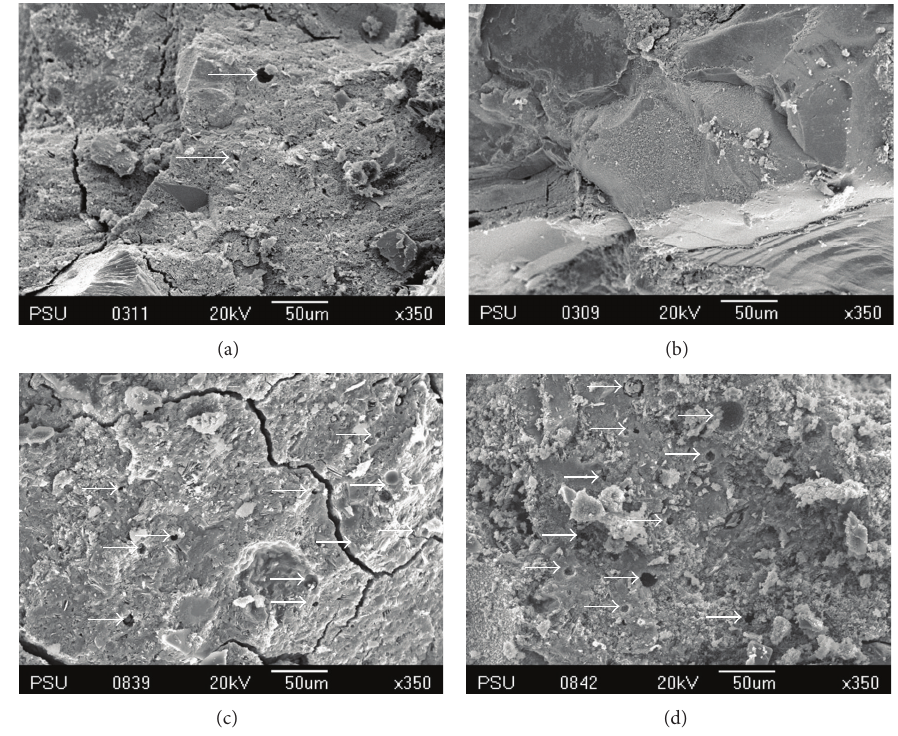
Figure 8: SEM micrograph of geopolymer mortar; (a) Control-2, (b) O5-2, (c) O10-2, and (d)